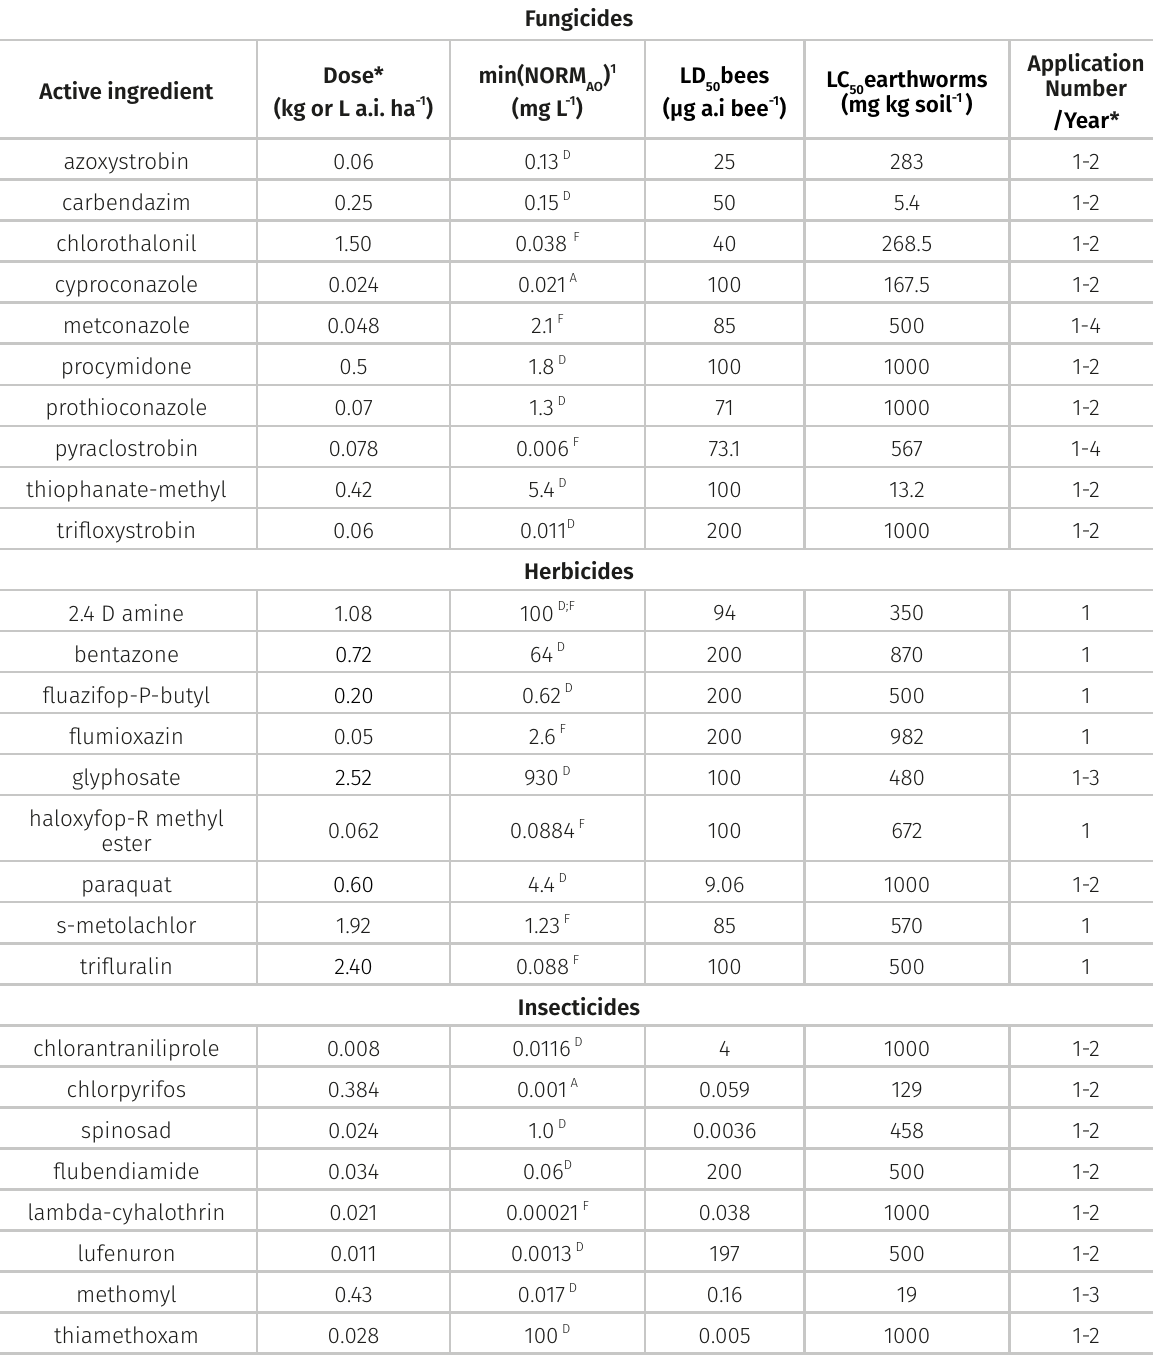
Table V. Ecotoxicological data on phytosanitary products recommended in soybean crops in Brazil used to calculate the risk indices of environmental contamination by drift.